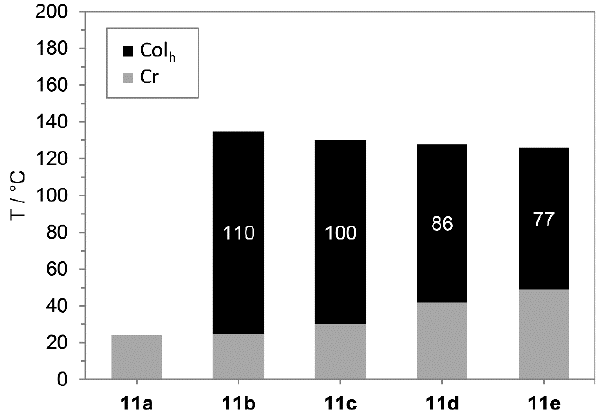
Figure 2. Mesophase stabilities of boroxines 11a – e upon second heating (heating rate 5 K·min −1 ). Mesophase widths are